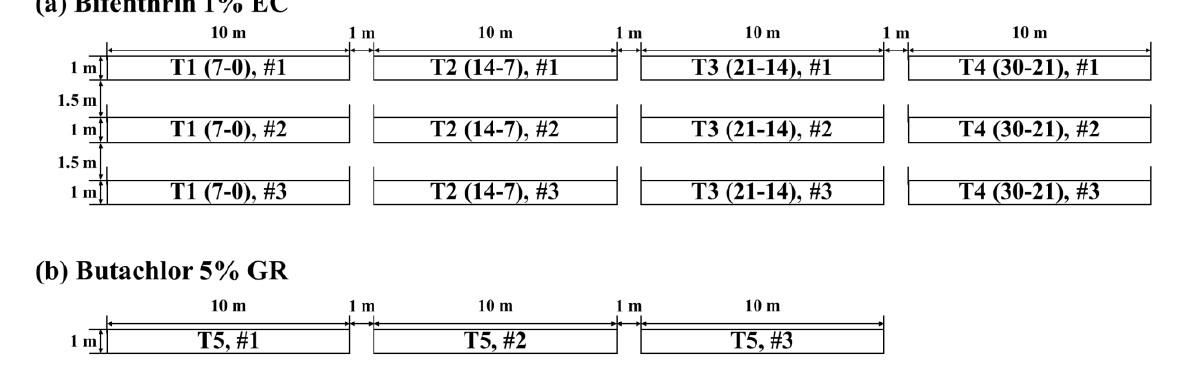
Figure 1. A design layout of the experimental fields in ( a ) Jeonju-si for bifenthrin 1 EC; ( b ) Jincheon- gun for butachlor 5 GR.